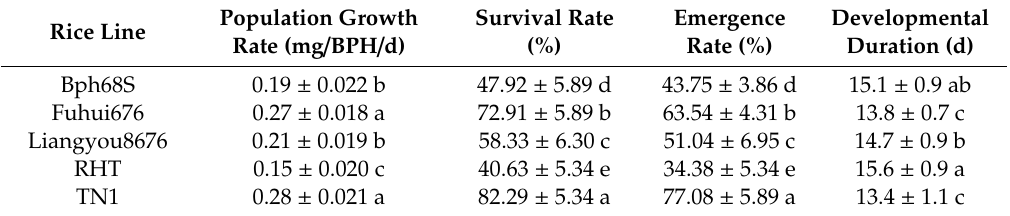
Table 1. The population growth, survival, emergence rates and developmental duration of nymphs on di ff erent rice